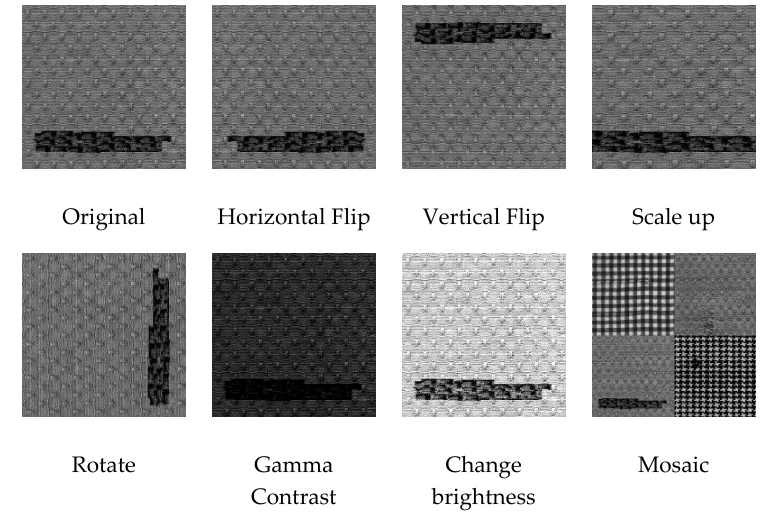
Figure 3. Data augmentation methods. Figure 3 . Data augmentation methods